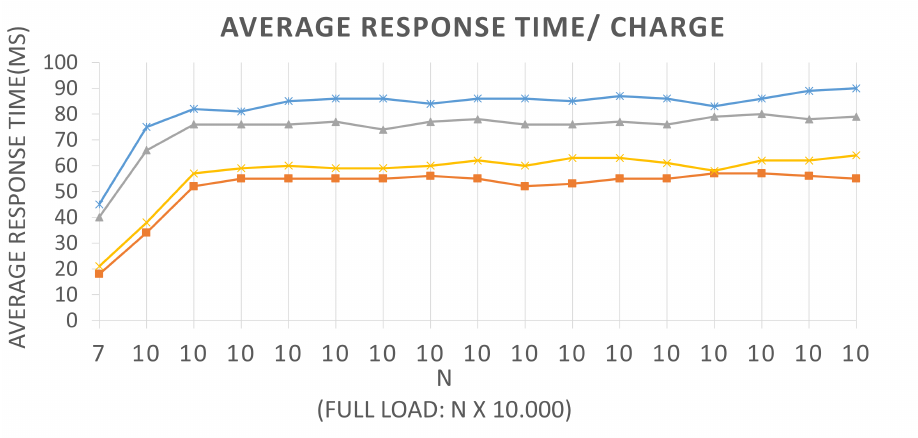
Figure 12. Results of the experiments for query